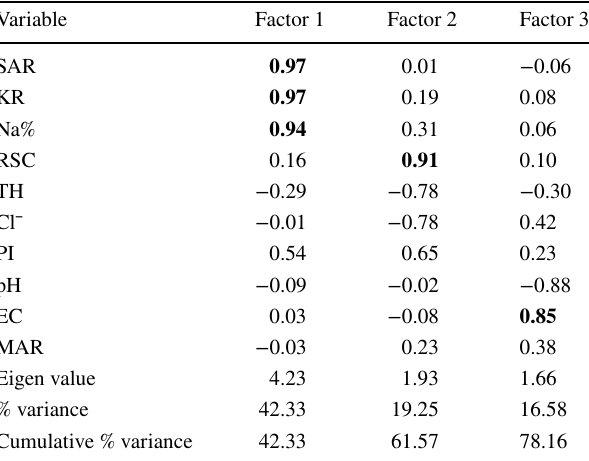
Table 4 Varimax rotated factor loading and eigenvalues of principal components